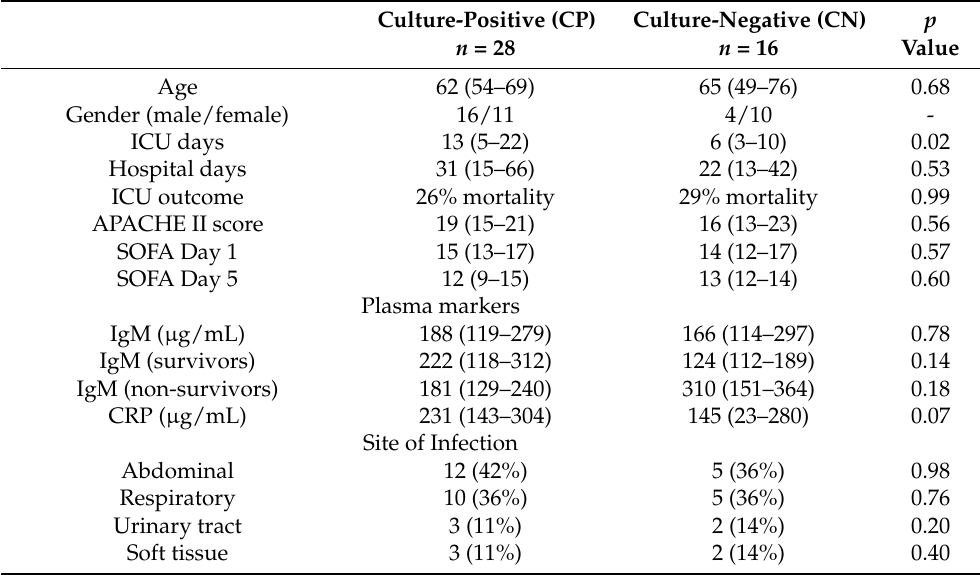
Data is presented as frequency (%) or median and interquartile range, (IQR) as appropriate. An unpaired non- parametric Mann–Whitney U test was used to determine the p value. ICU: Intensive care unit; APACHE II: Acute Physiology and Chronic Health Evaluation Score II; SOFA: Sequential Organ Failure Assessment score; IgM: Immunoglobulin M; CRP: C-reactive protein.